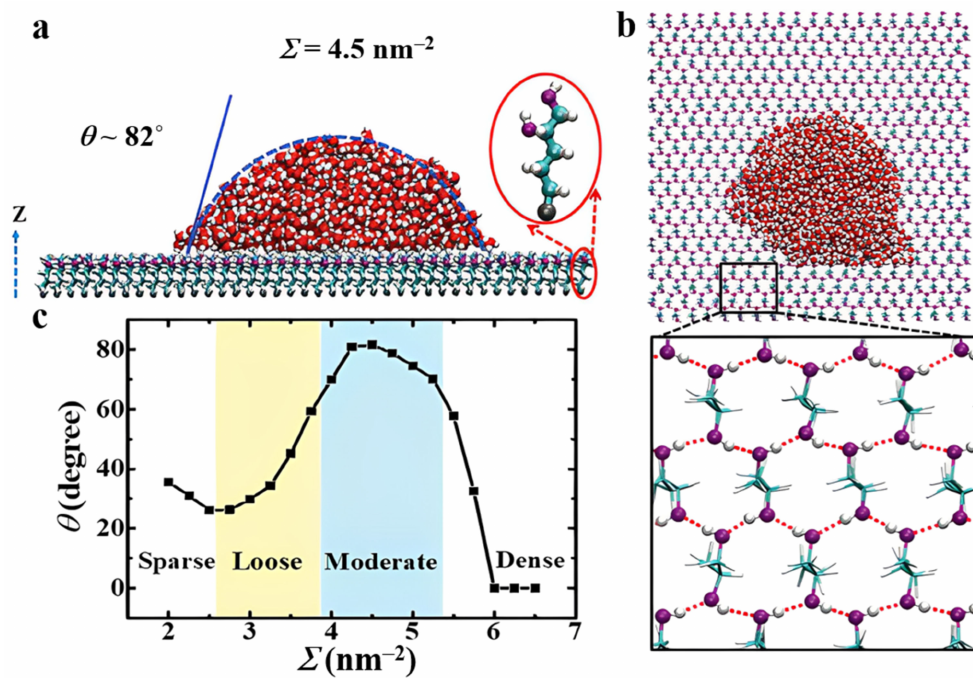
Figure 5. ( a ) Side-view snapshot of a water droplet with large contact angle of 82 ◦ on (OH) 2 -SAM with two hydroxyl (OH) groups at a packing density of Σ = 4.5 nm − 2 (model atoms, gray; hydroxyl groups: purple and white; water: red and white; and alkyl chains: cyan and white). ( b ) Top-view snapshot (top) of the subfigure (bottom) with an enlarged region where a hexagonal-like H-bonding structure on (OH) 2 -SAM appears. ( c ) Contact angle θ of the water droplets on (OH) 2 -SAMs versus packing density Σ . (Reprinted from Ref. [133], Copyright 2021 Royal Society of